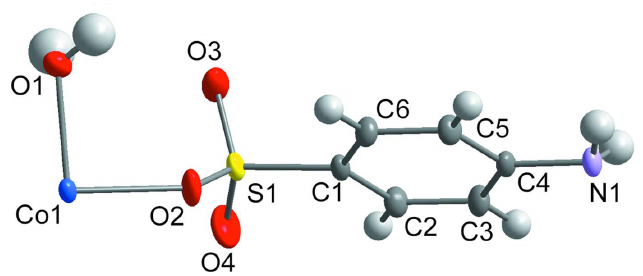
Figure 1 The asymmetric unit of the title compound. Displacement ellipsoids are drawn at 50% probability level.